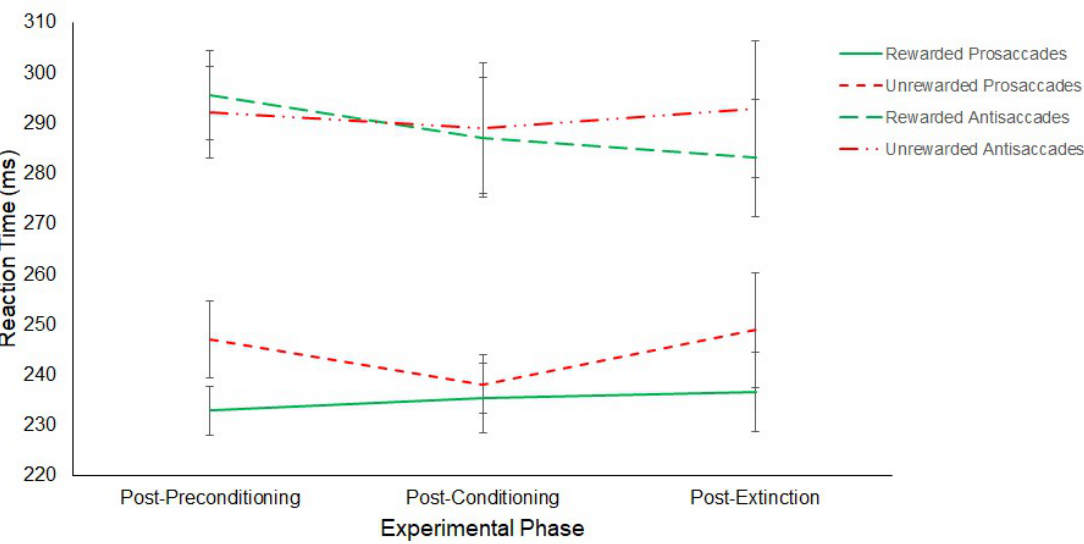
Figure 9. Latency of prosaccades and antisaccades to the rewarded and unrewarded hemifields across the post-preconditioning, post-conditioning and post-extinction phases of the reward paradigm in Experiment 2. Error bars show +/−1 SEM.